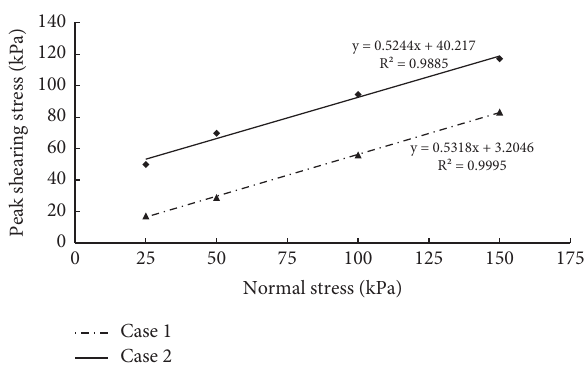
Figure 10: Fitting curve of shear strength.